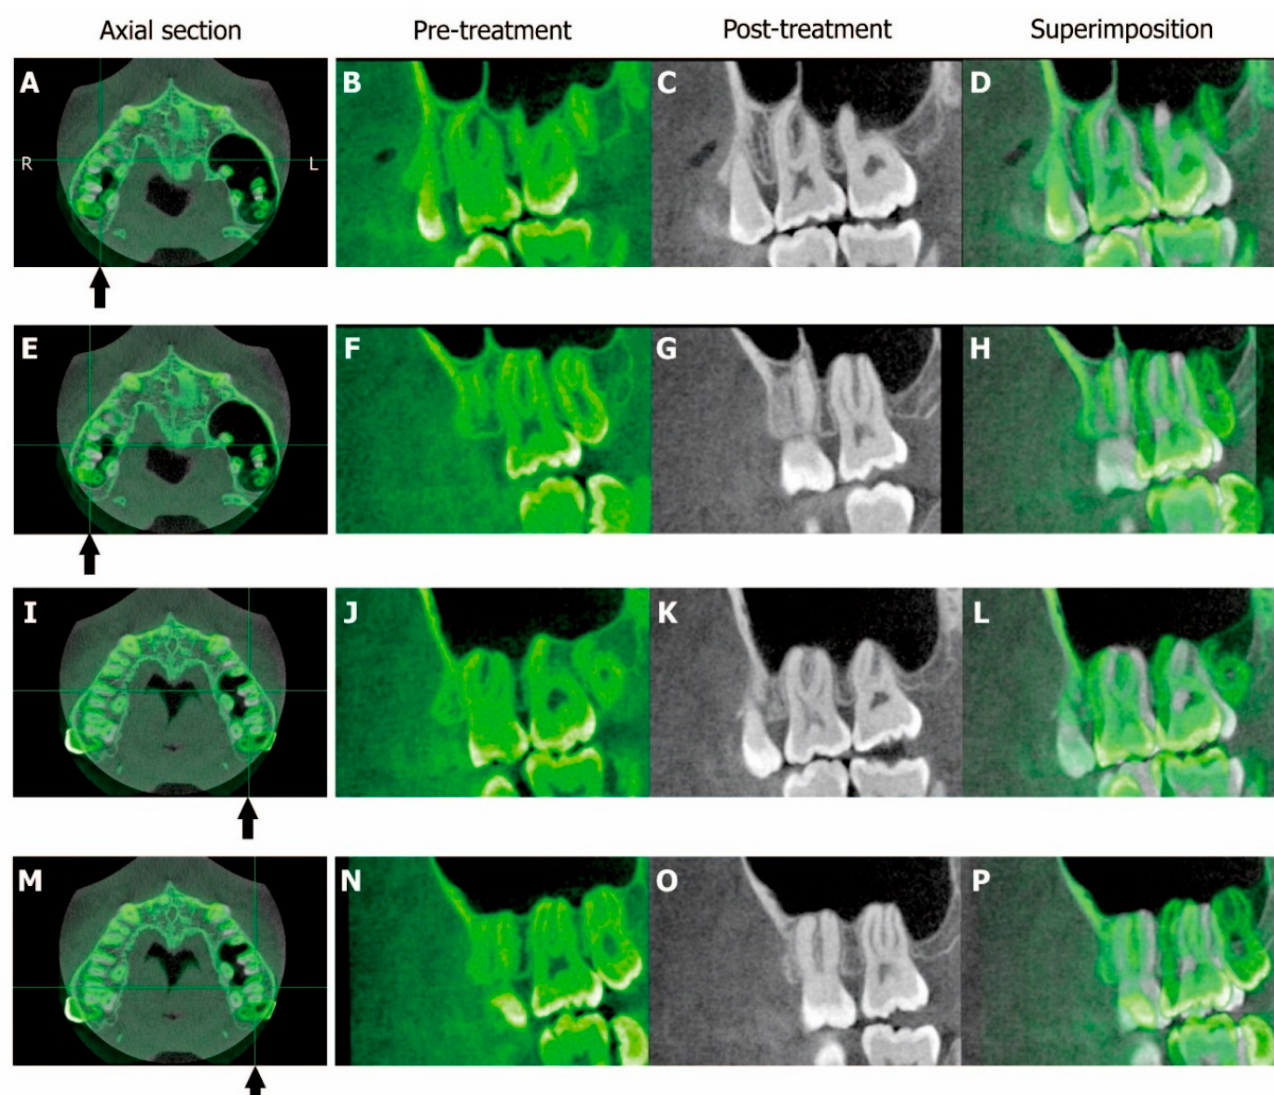
Figure 14. Three-dimensional cone-beam computed tomography (CBCT) images of the relationships between the maxillary molars and maxillary sinus. ( A – D ) CBCT axial section at the right first molar level ( arrow ), CBCT sagittal sections at post-treatment ( gray ) and pretreatment ( green ), and their superimposition; ( E – H ) CBCT axial section at the right second molar level ( arrow ), CBCT sagittal sections at post-treatment ( gray ) and pretreatment ( green ), and their superimposition; ( I – L ) CBCT axial section at the left first molar level ( arrow ), CBCT sagittal sections at post-treatment ( gray ) and pretreatment ( green ), and their superimposition; ( M – P ) CBCT axial section at the left second molar level ( arrow ), CBCT sagittal sections at post-treatment ( gray ) and pretreatment ( green ), and their superimposition. Table 2. Distal and palatal movement of the maxillary first and second molars measured with su- perimposed CBCT images.